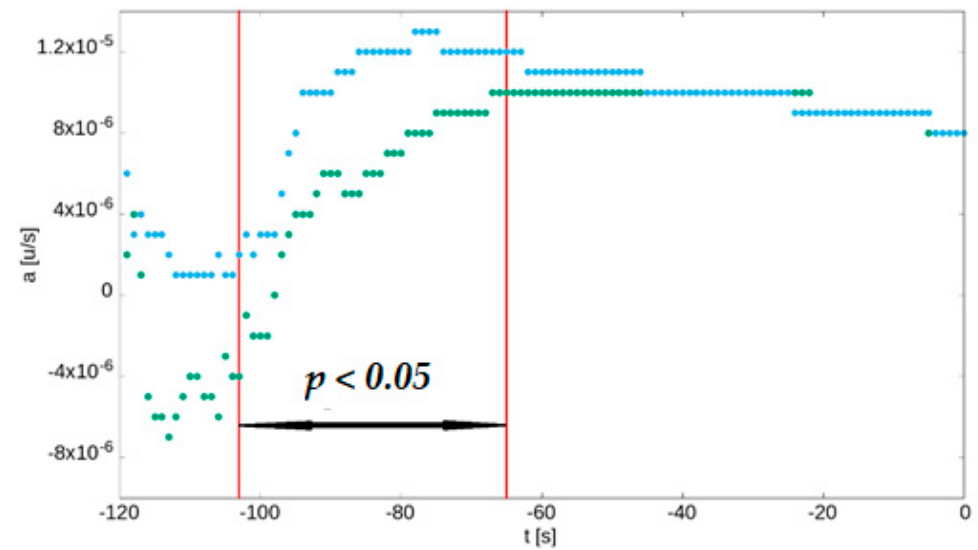
Figure 3. Median values of 1-s slopes ( values of a from linear regression over every 25 consecutive samples of normalised fluorescence ) for rest and the 100-s forearm skin ischaemia. During the earliest skin ischaemia, patients with HA (blue dots) had higher slopes than healthy people (green dots).